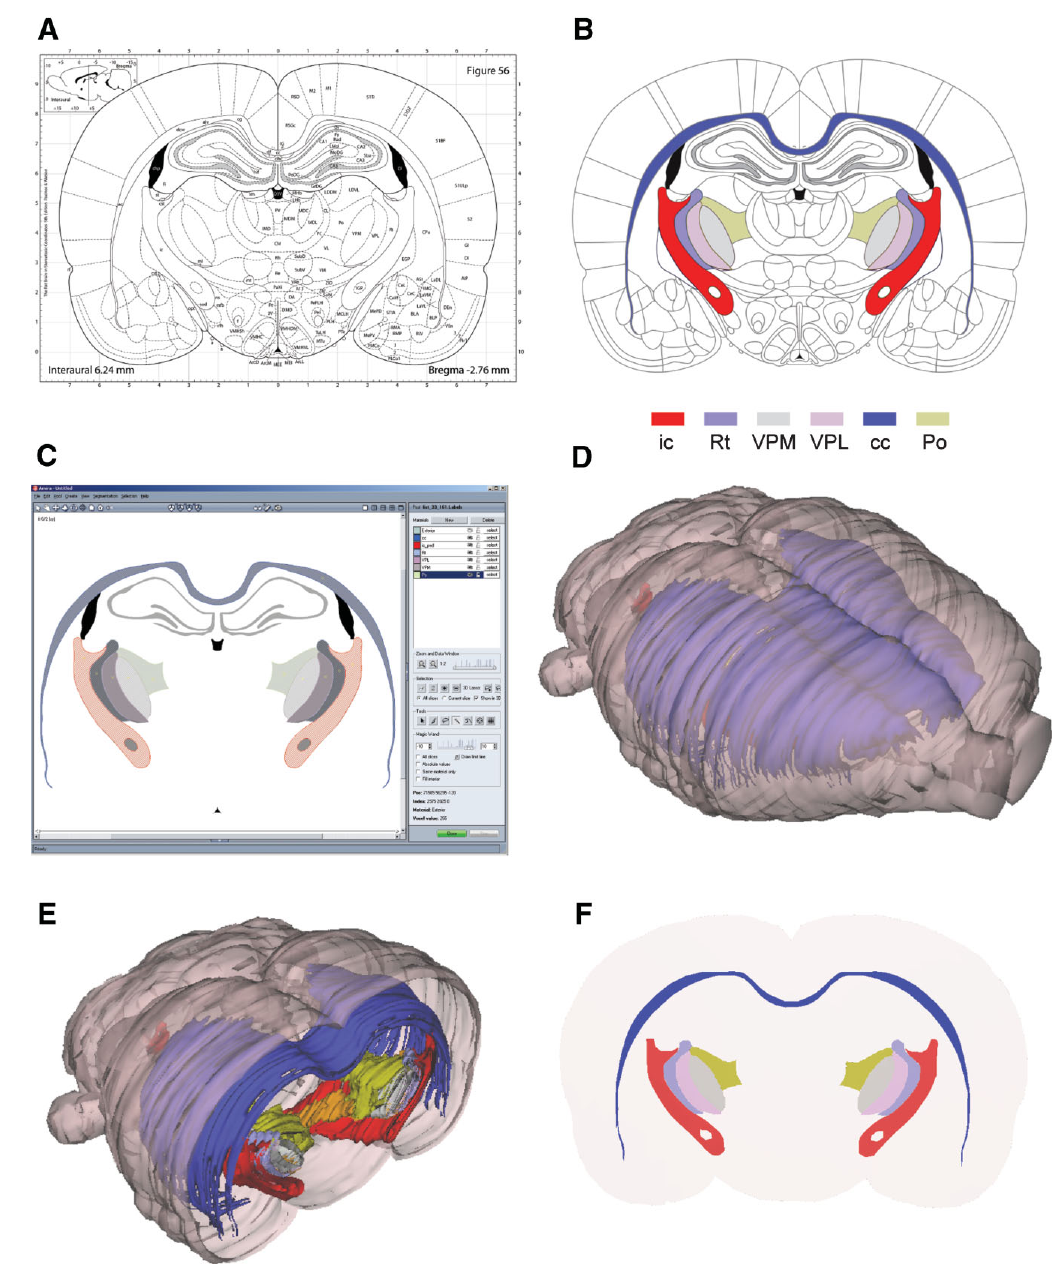
Figure 1. Thestepwise3-Datlasreconstructionprocedure. ( A )Acoronalratbrainatlasdiagram(reproducedfromPaxinosandWatson,2005,withpermission) with the stereotaxic grid, section number, structure labeling and the distance from bregma indicated. ( B ) The same diagram imported to Illustrator, where regions of interest (ROIs) are selected and assigned a color code. ( C ) Image of the Amira GUI showing segmented ROIs. ( D ) Selected 3-D reconstructed structures visualized in the m3d tool. ( E ) The same reconstruction as shown in ( C ) coronally sub-divided using the m3d slicing module. ( F ) Customized atlas diagram, corresponding to ( A ), exported from m3d. A separate module in m3d is used to render the sub-divided surfaces as solid objects. ic, internal capsule; Rt, reticular